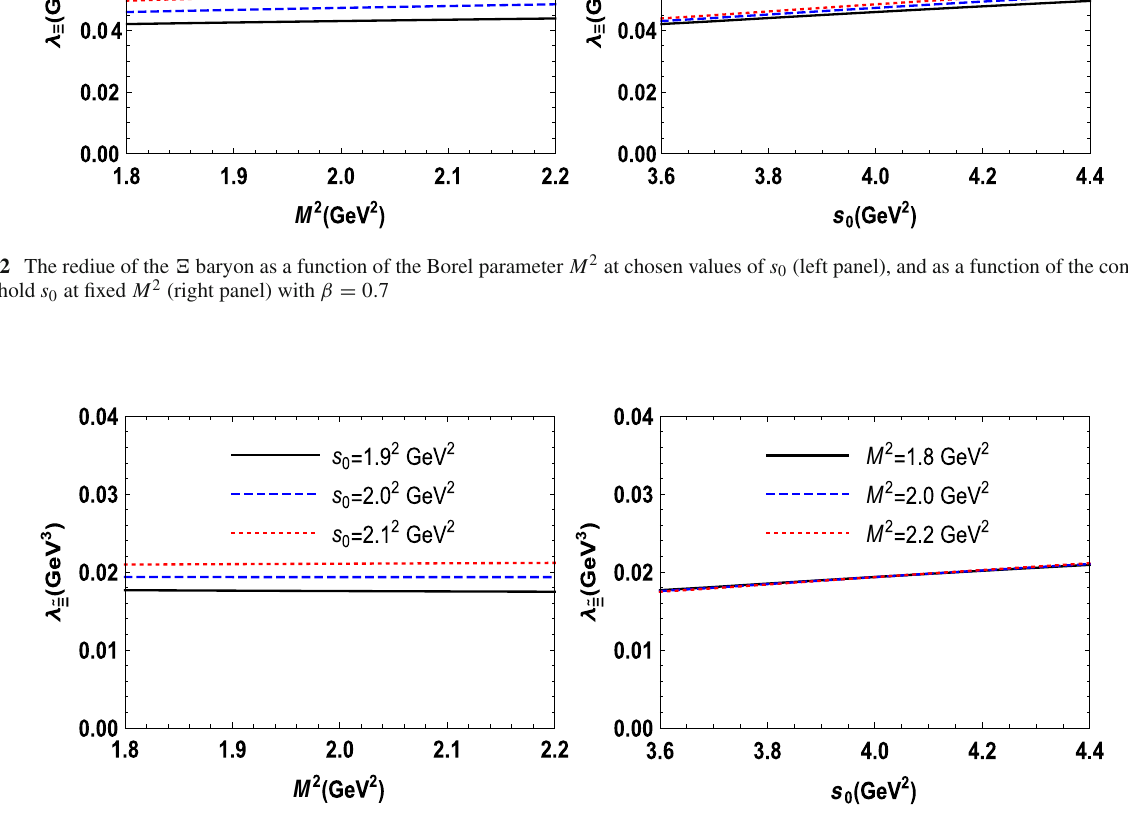
Fig. 3 The same as in Fig. 2, but for the orbitally excited (cid:2) (cid:2) baryon with β = 0 .